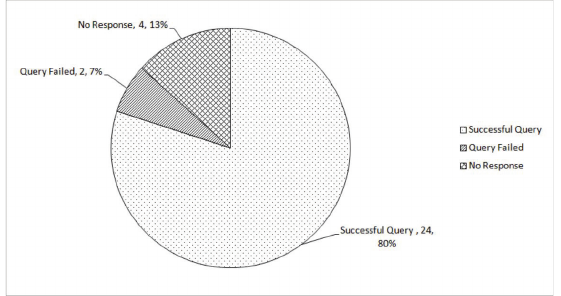
Fig. 7. Query successful vs. unsuccessful - Affinity method